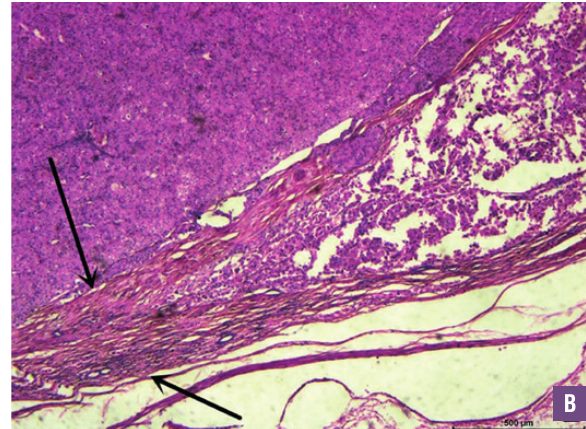
figure 2 B - Microscopic investigation reveals the pseudocapsule of chRcc had cancer cell infiltration, but without penetration (HE*40).